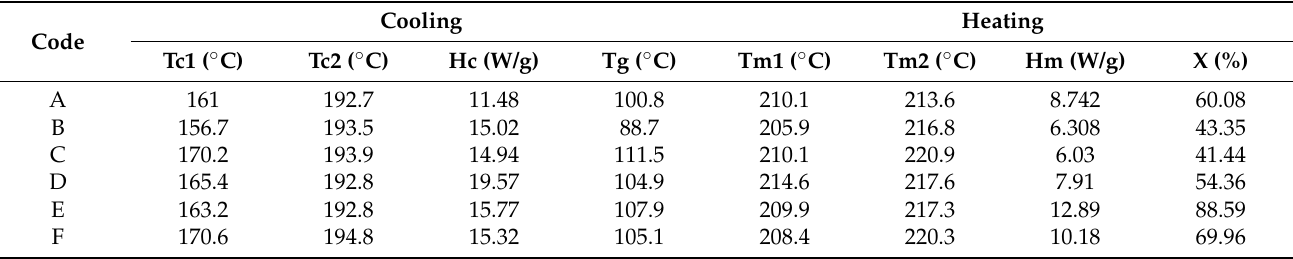
Table 3. DSC studies of starch–PVA